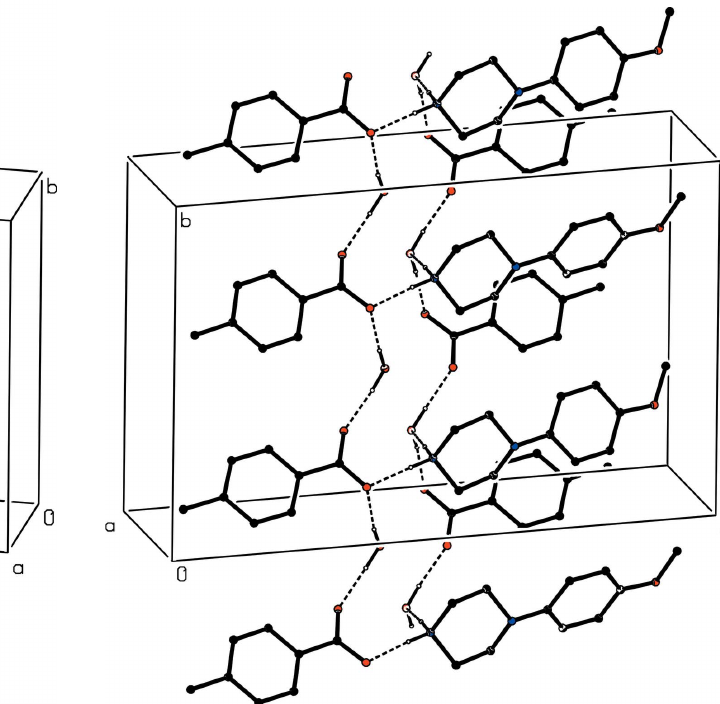
Figure 5 Part of the crystal structure of compound (I) showing the formation of a ribbon of R 7 (20) rings running parallel to [010]. Hydrogen bonds are 8 drawn as dashed lines and, for the sake of clarity, the H atoms bonded to C atoms have been